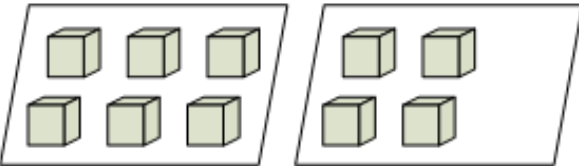
Figure 3. A reasonable arrangement.